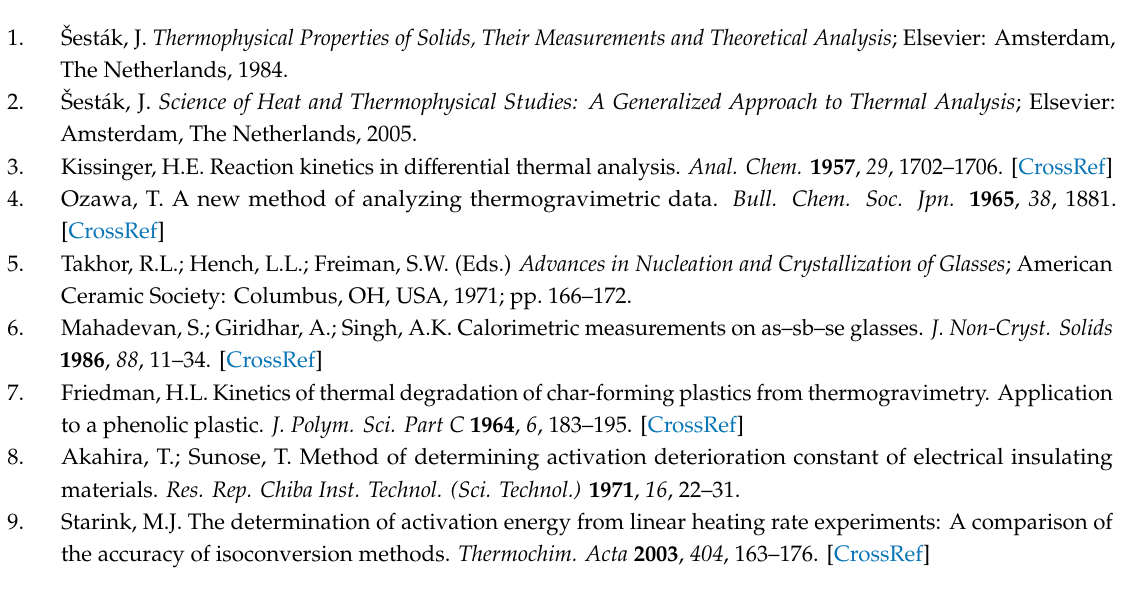
Figure S1: Errors for the group 1 datasets A and G simulated for 10 k and 50 k points / curve. Figure S2: Errors for the group 1 datasets B, C, D and E simulated for 10 k points / curve. Figure S3: Errors for the group 1 dataset F simulated for 5, 10, 20 and 50 k points / curve. Figure S4: Errors for the group 2 datasets A, B, C and D simulated for I 1 / I 2 = 50 / 50. Figure S5: Errors for the group 2 datasets E, F, G and H simulated for I 1 / I 2 = 50 / 50. Figure S6: Errors for the group 2 datasets A, B, C and D simulated for I 1 / I 2 = 30 / 70. Figure S7: Errors for the group 2 datasets E, F, G and H simulated for I 1 / I 2 = 30 / 70. Figure S8: Errors for the group 2 datasets A, B, C and D simulated for I 1 / I 2 = 70 / 30. Figure S9: Errors for the group 2 datasets E, F, G and H simulated for I 1 / I 2 = 70 / 30. Figure S10: Example AC data-curve simulated for 5 ◦ C / min. Figure S11: E- α dependences obtained for AC data with I 1 / I 2 = 30 / 70. Figure S12: E- α dependences obtained for AC data with I / I = 50 / 50. Figure S13: E- α dependences 1 2 obtained for AC data with I 1 / I 2 = 70 /